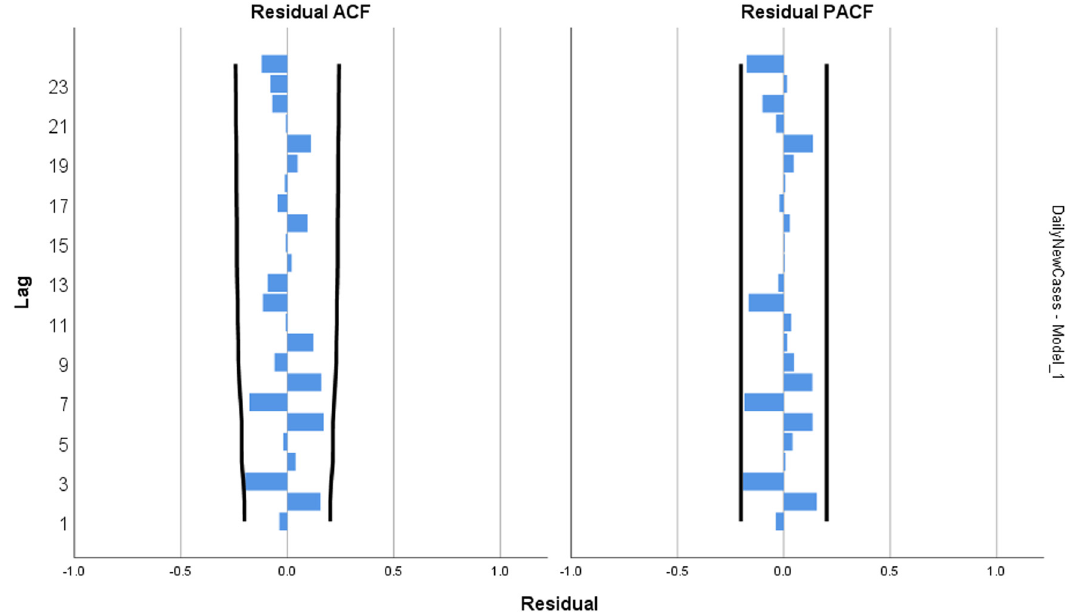
Figure 6: The residual of ACF and PACF of ARIMA ( 1,1,1 )